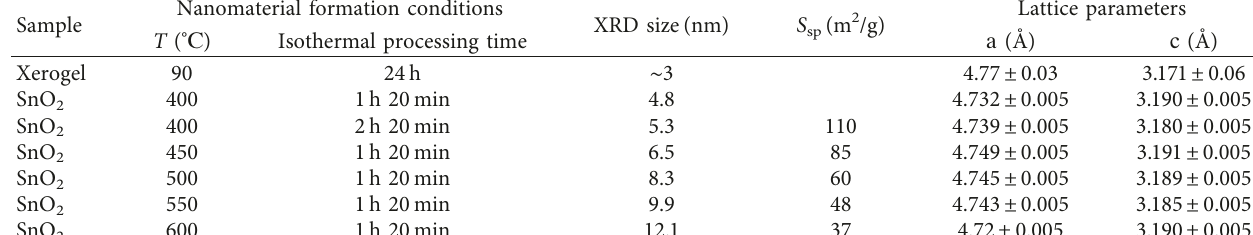
Table 1: Particle sizes of SnO 2 calculated by using the Scherrer equation, lattice parameters, and specific surface areas of the nanomaterials obtained through thermal treatment of the xerogel.